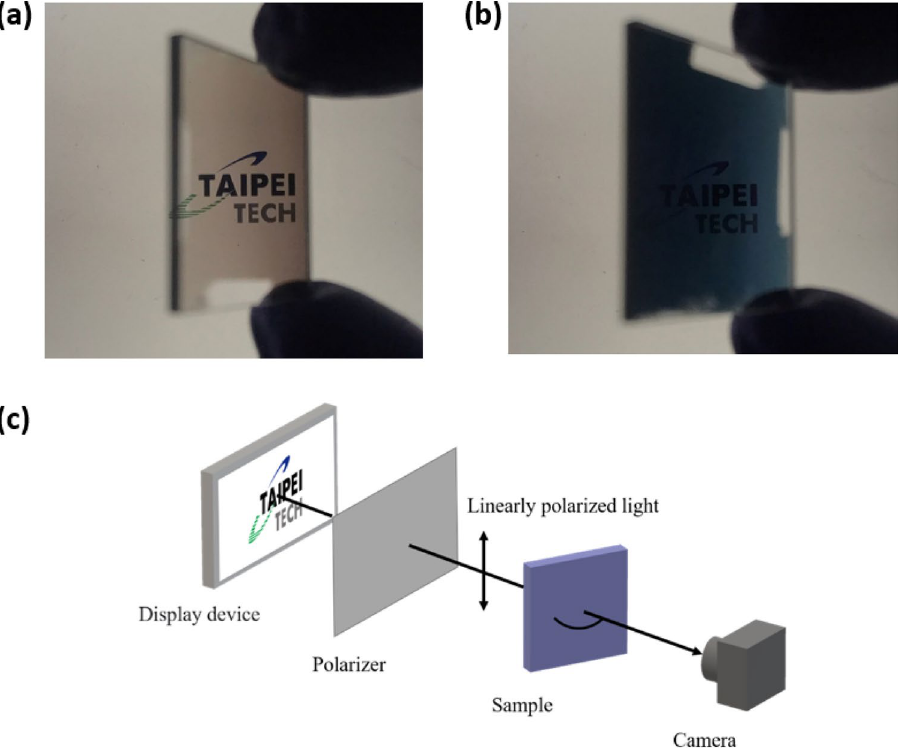
Figure 3. P-polarized transmitted images captured at ( a ) (ϕ , θ) = ( 0 ◦ , 60 ◦ ) and ( b ) (ϕ , θ) = ( 0 ◦ , − 60 ◦ ) ; (c) Setup for image